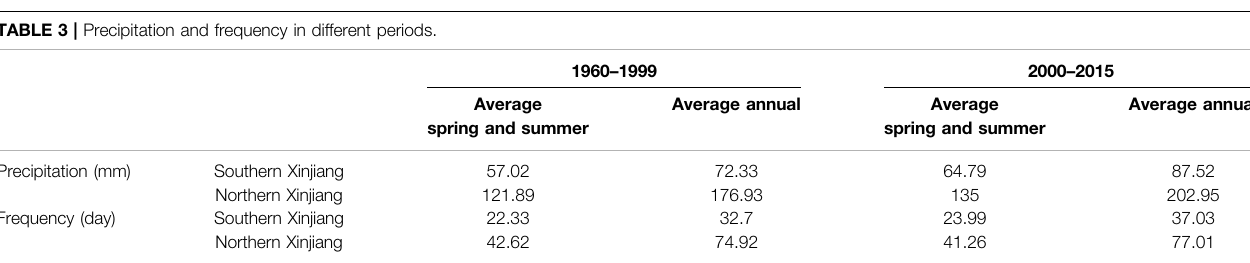
TABLE 3 | Precipitation and frequency in different